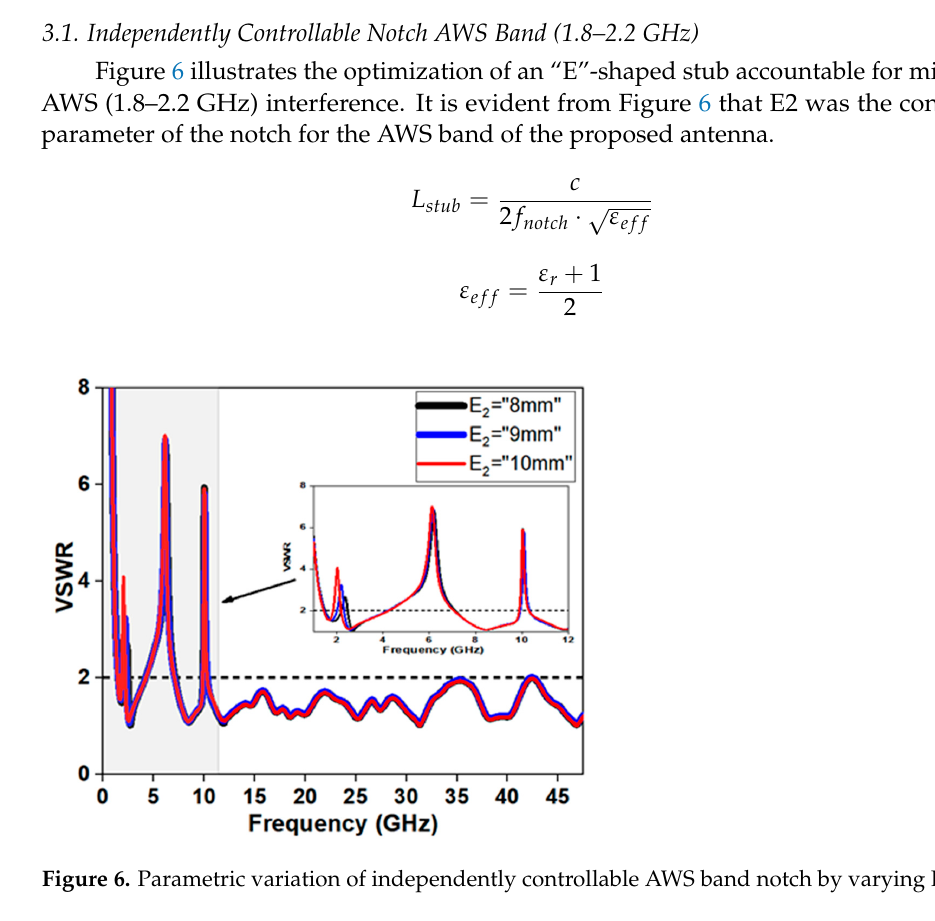
Figure 6 . Parametric variation of independently controllable AWS band notch by varying E2 .